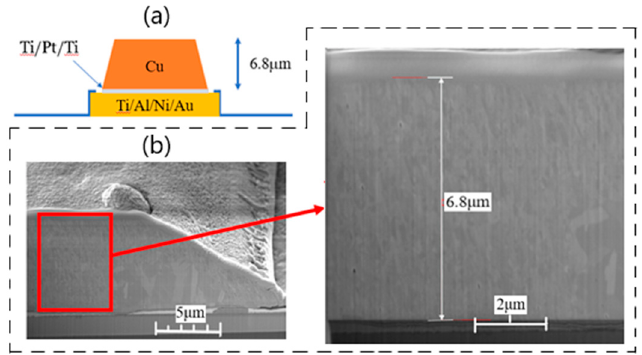
Figure 1. AlGaN/GaN high-electron-mobility transistors (HEMTs) epitaxial configuration and device structure with scanning electron microscope (SEM) image of the gate.